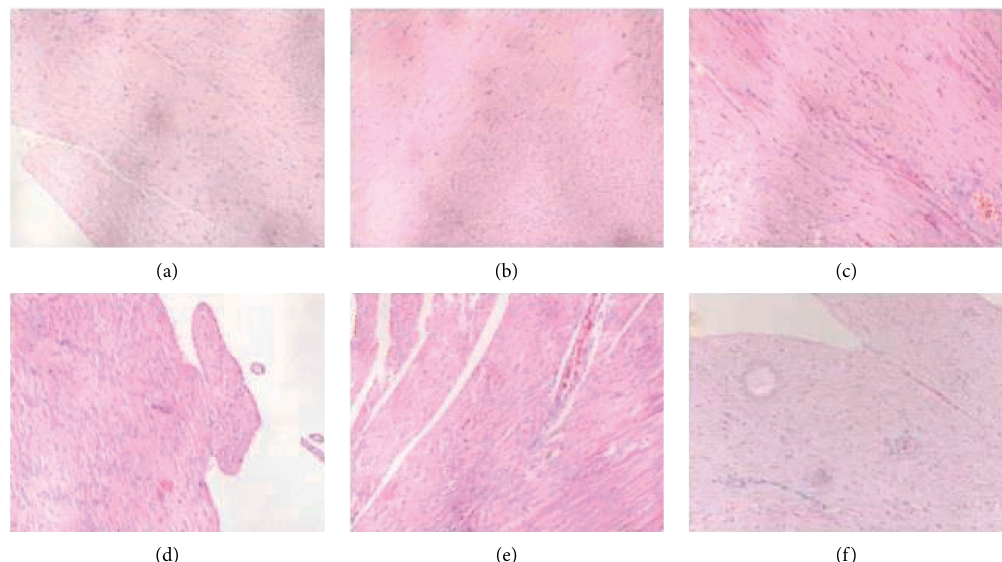
Figure 3: HE staining of left ventricular myocardium of two groups ( × 100) sham: sham-operated group; 2K2C: 2K2C hypertension group.